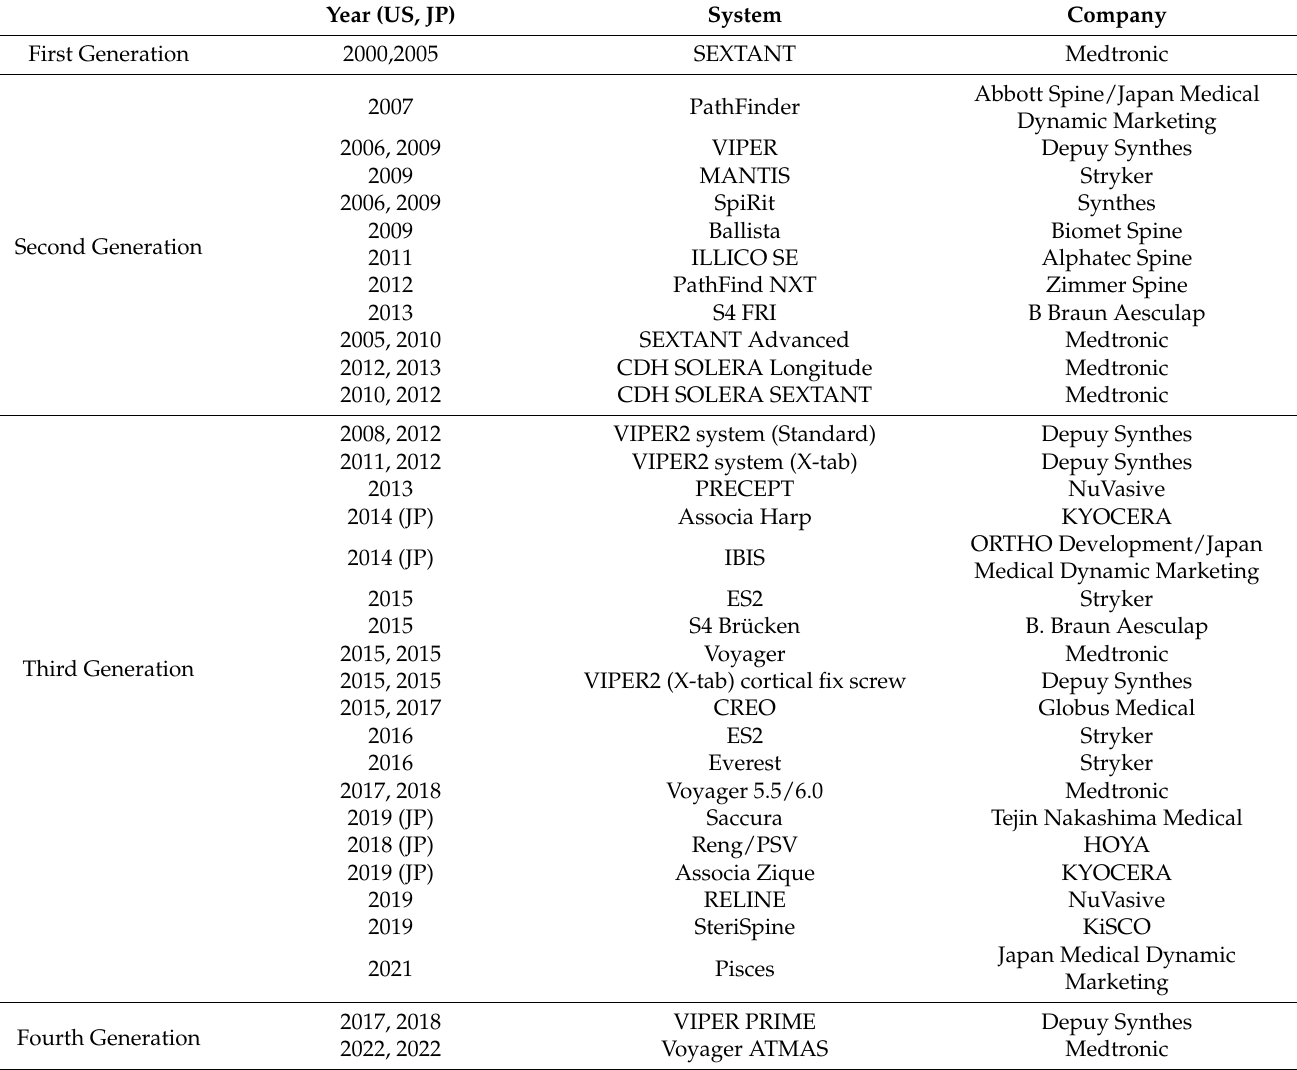
Table 1. Commercially Available PPS